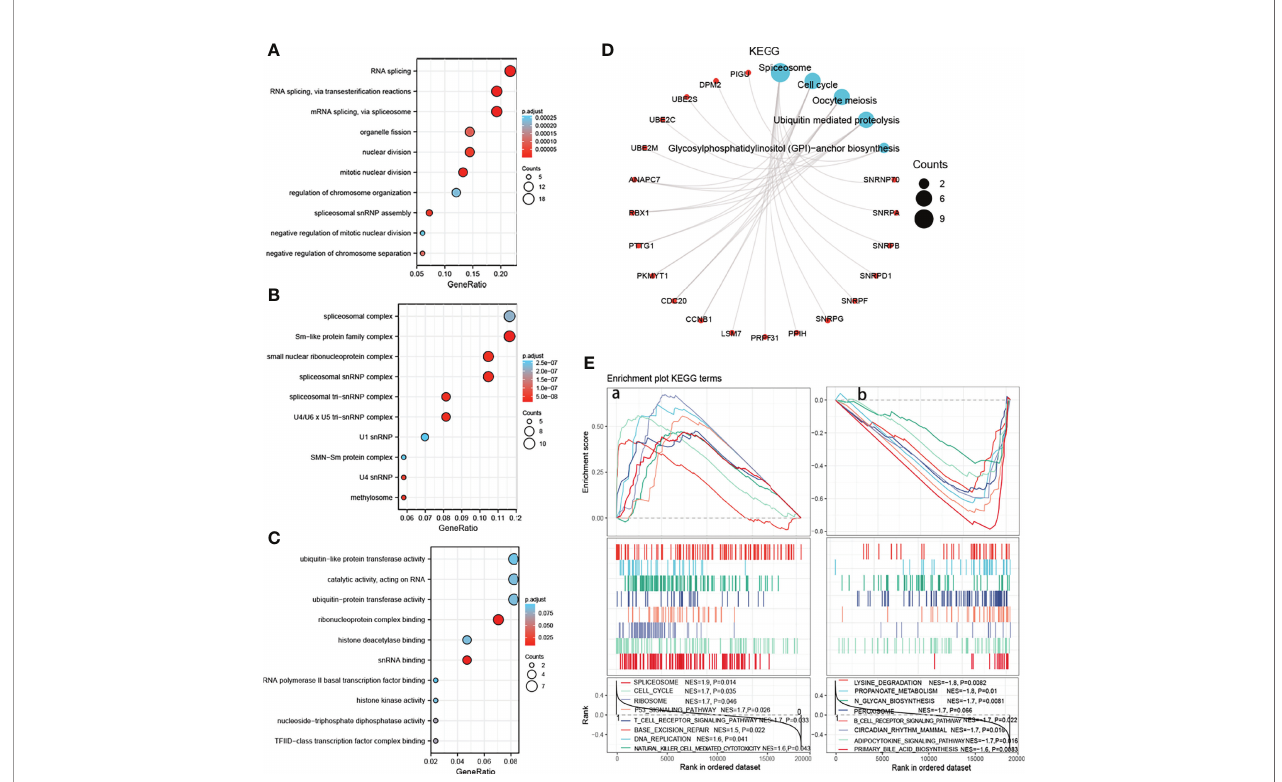
FIGURE 7 | Functional enrichment analysis of SNRPA in HCC. (A – C) The bubble diagram for the biological process (A) , cellular component (B) , and molecular function (C) data in GO analysis. (D) The KEGG pathway enrichment analysis of co-expressed genes with SNRPA . (E) Identi fi cation of signi fi cant signaling pathways enriched in the high SNRPA mRNA expression patients (A) and low SNRPA mRNA expression patients (B) by